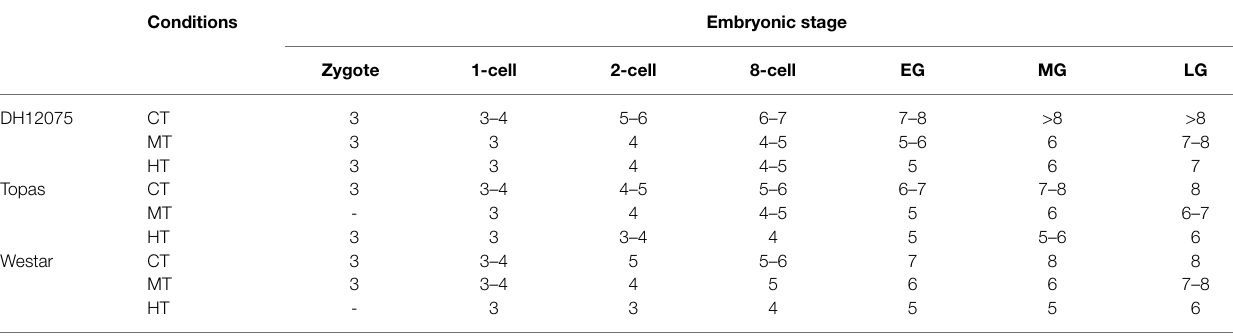
TABLE 2 | Most abundant embryo stages per DAP (>20% of the embryos per silique at the given